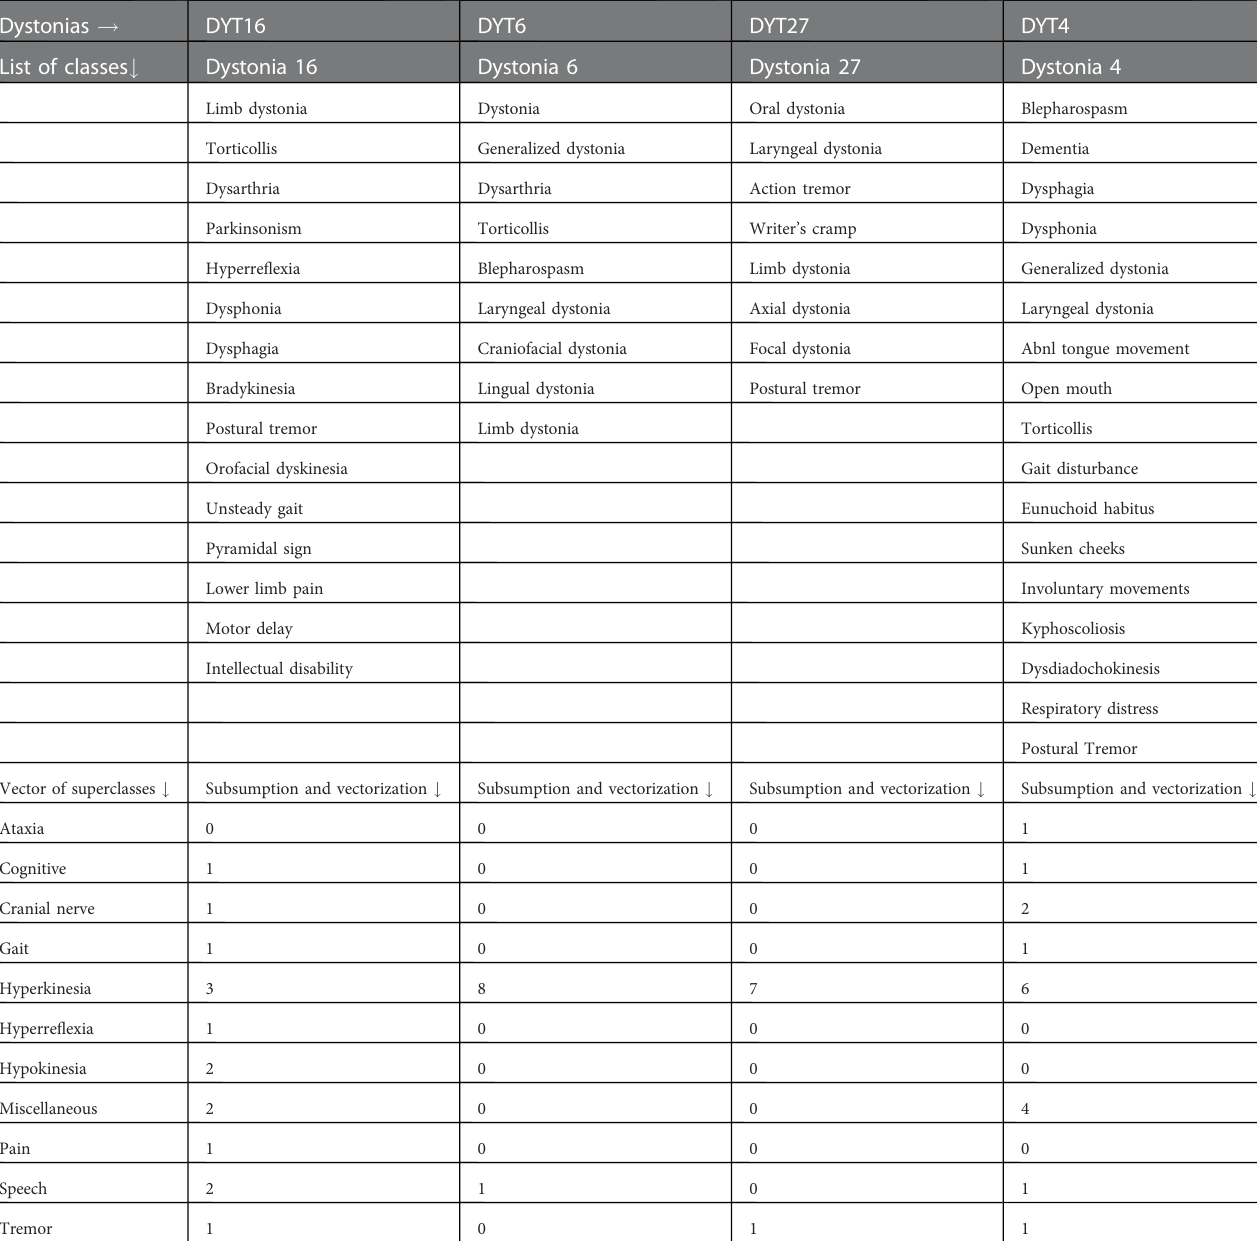
TABLE 1 The upper half of the Table shows lists of signs and symptoms for each dystonic disease from